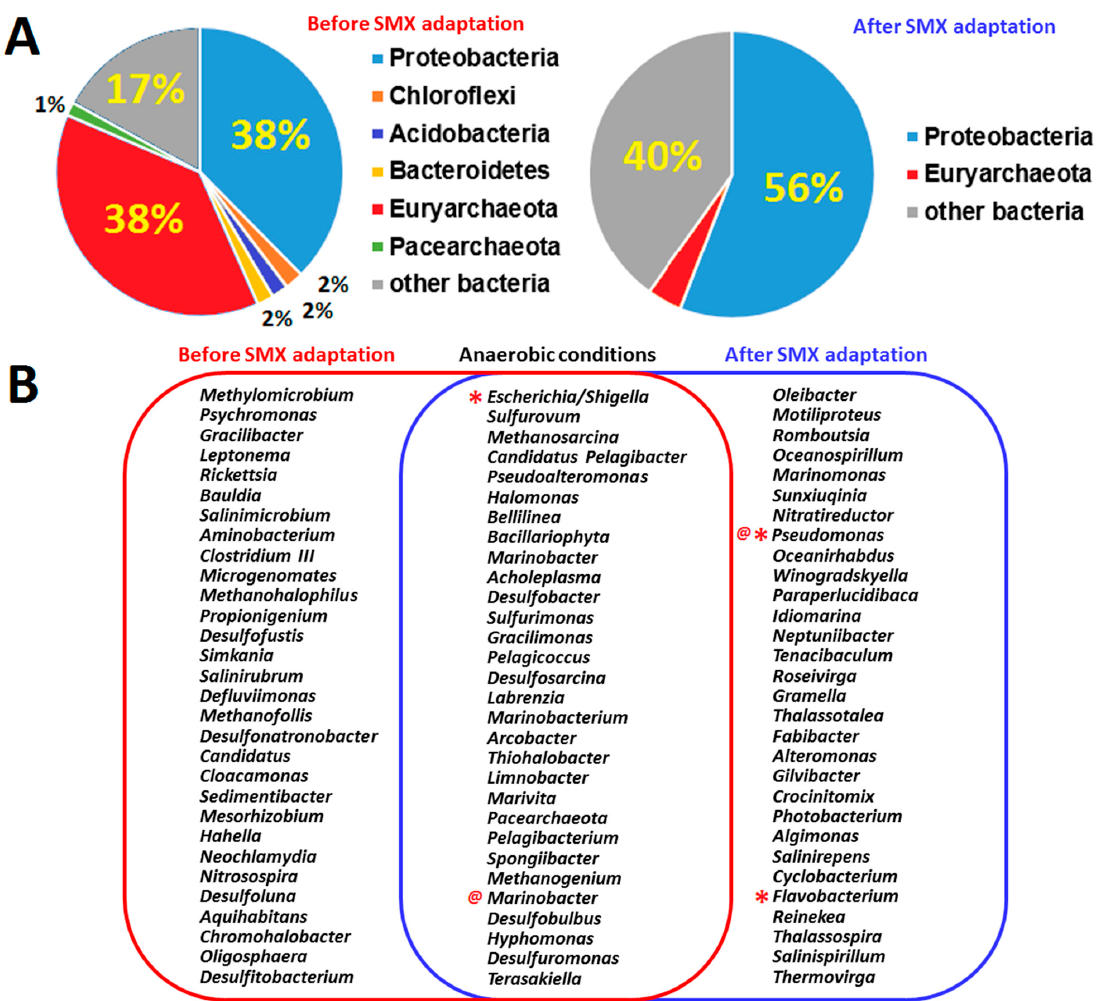
Figure 3. Bacterial / archaeal community in milkfish ( Chanos chanos ) pond sediments under anaerobic condition before and after sulfamethoxazole (SMX) adaptation. ( A ) Major bacterial / archaeal community (phylum level) in the sediments under anaerobic conditions before and after SMX adaptation. ( B ) Major bacterial / archaeal community (genus level) in the sediments under anaerobic conditions before and after SMX adaptation. Red stars indicate SMX-degrading bacteria that have been reported. Red “@”s indicate SMX-degrading bacteria that were isolated in this study.